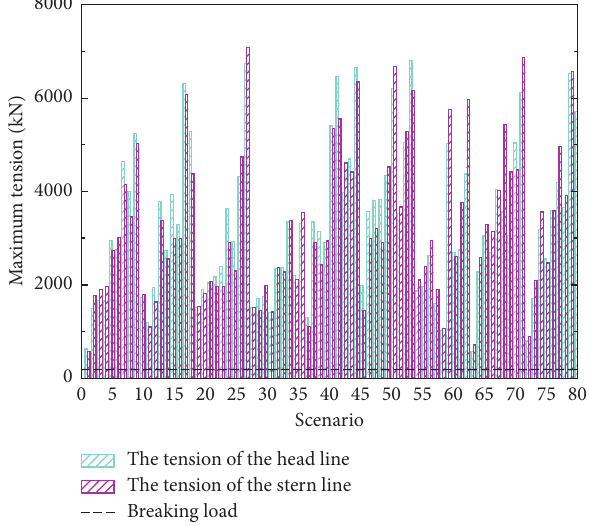
Figure 13: Maximum line tensions in convex bank.